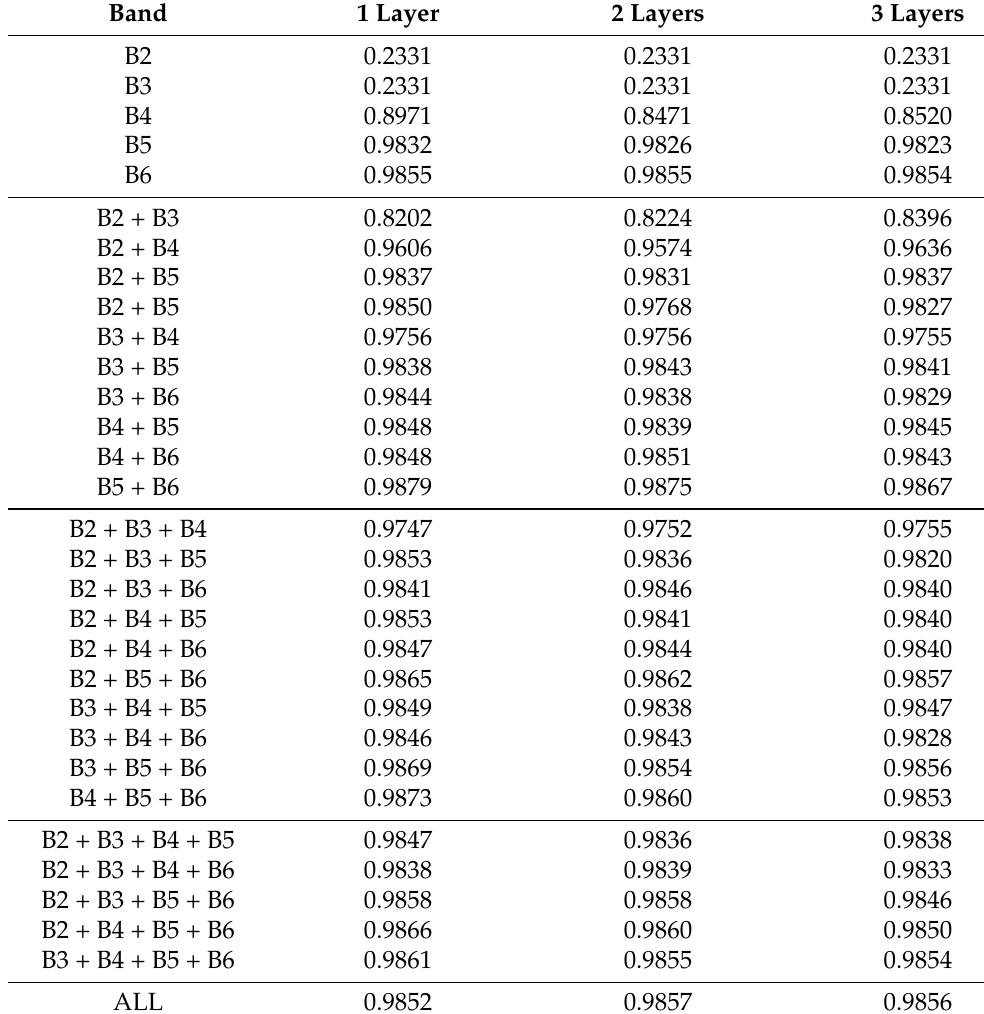
Table 2. Performance based on mIoU in combination of different band and various numbers for semantic feature extraction CNN